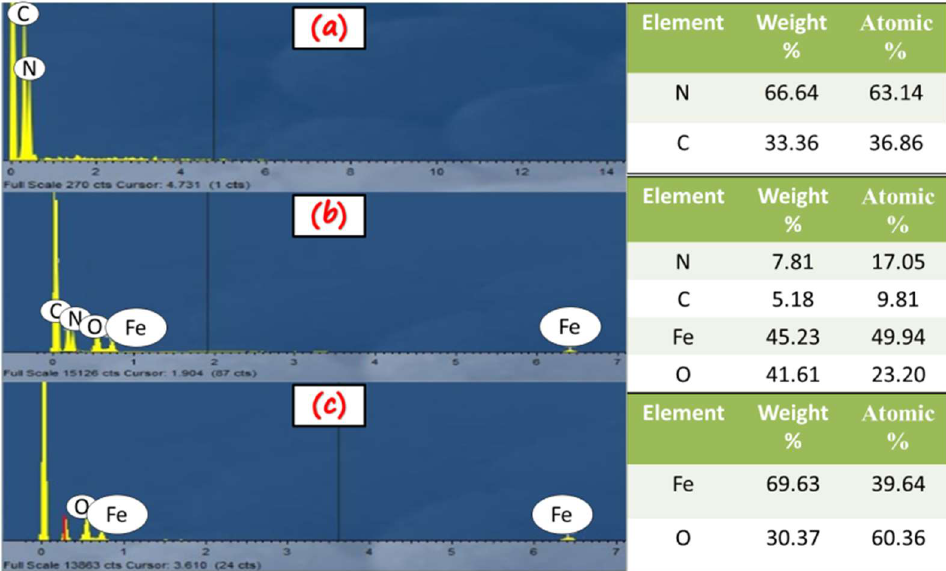
Figure 3. EDS spectra of: ( a ) g-C 3 N 4 , ( b ) α-Fe 2 O 3 , and ( c ) g-C 3 N 4 /α-Fe 2 O 3 with quantification of atomic percentages.